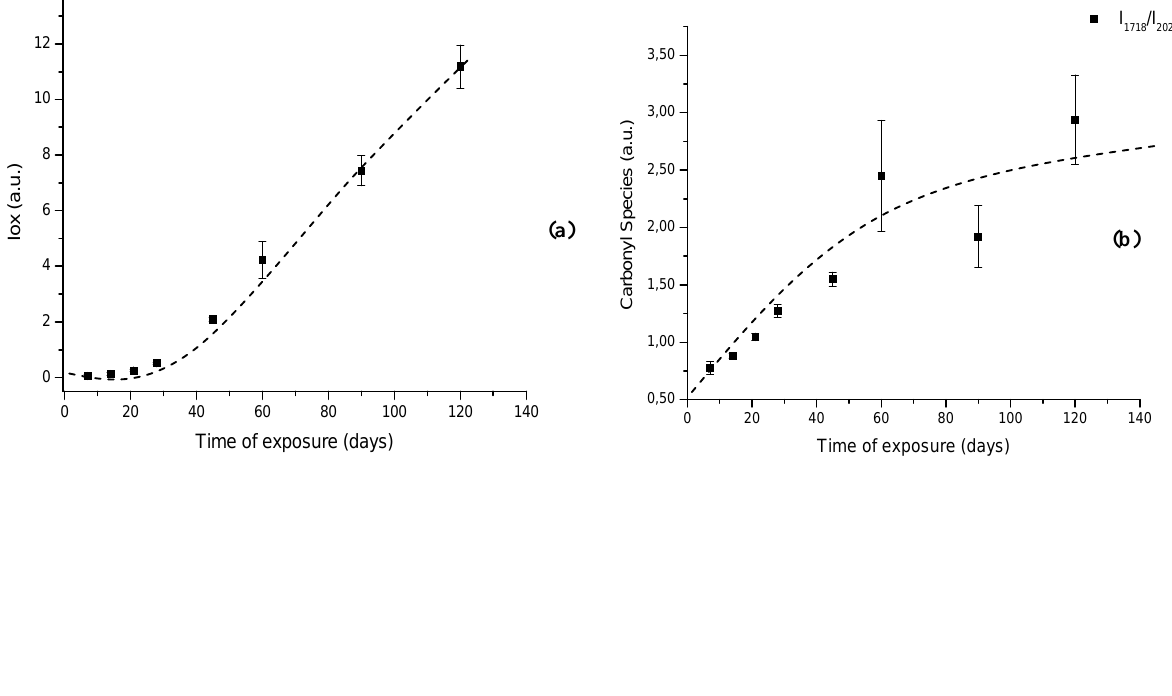
Figure 7. (a) Evolution of UHMWPE degradation in H Oxidation Index (Iox) at different aging times. (b) Specific carbonyl group index (I related to polymer oxidation up to 120